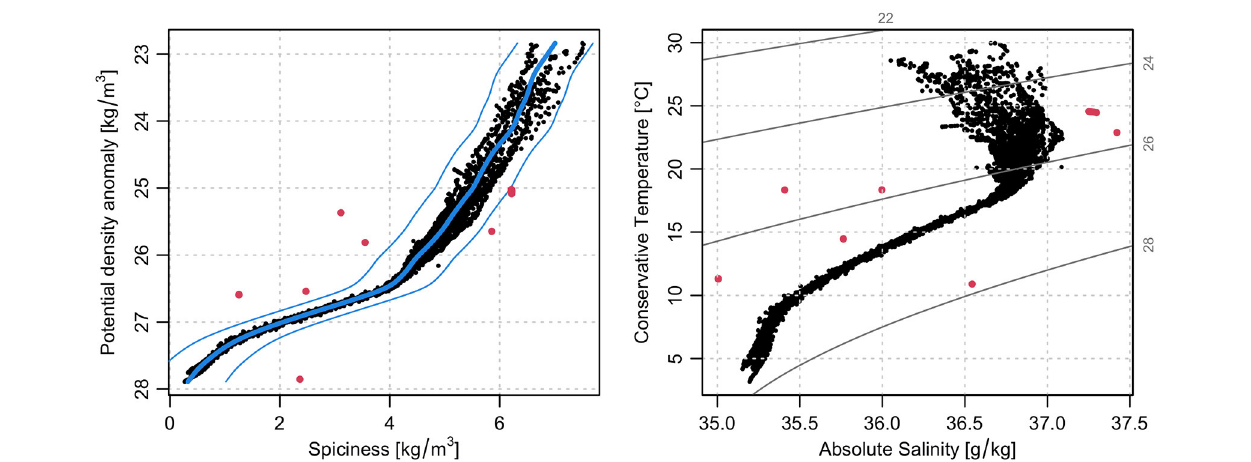
FIGURE 8 | Demonstration of non-standard QC analysis based on scatter from the data cloud, using the same dataset as in Figure 7 . (Left) covariation of potential density anomaly, σ θ , and spiciness parameter, 5 . The thick blue line is a smoothing spline expressing 5 as a function of σ θ , and the thinner lines indicate plausibility boundaries defined by 5 times the standard deviation of the model misfit. Points outside this boundary are colored red. (Right) temperature-salinity diagram as in Figure 7 , but with red for points that are outside the 5 ( σ θ ) spline boundary.